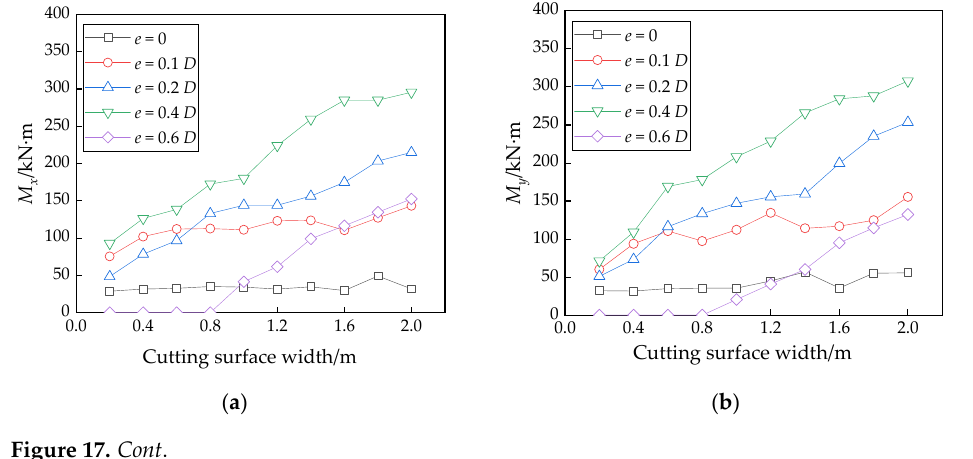
Figure 16. Effect of the cutting surface width B on the interaction forces: ( a ) F x ; ( b ) F y and ( c ) F z . The relations between the moments M x , M y , M z and cutting surface width B under different eccentric distances are shown in Figure 17. In a similar way as the interaction force, the moments increase with the width of the cutting surface, and the moment M z increases more significantly. M z , which can be considered as the additional torque of the shield cutter head, is also much greater than M x and M y , which are considered unbalanced moments. Therefore, it can be inferred that the adequate torque for the shield machine is required to ensure that the shield can cut piles and pass through quickly.